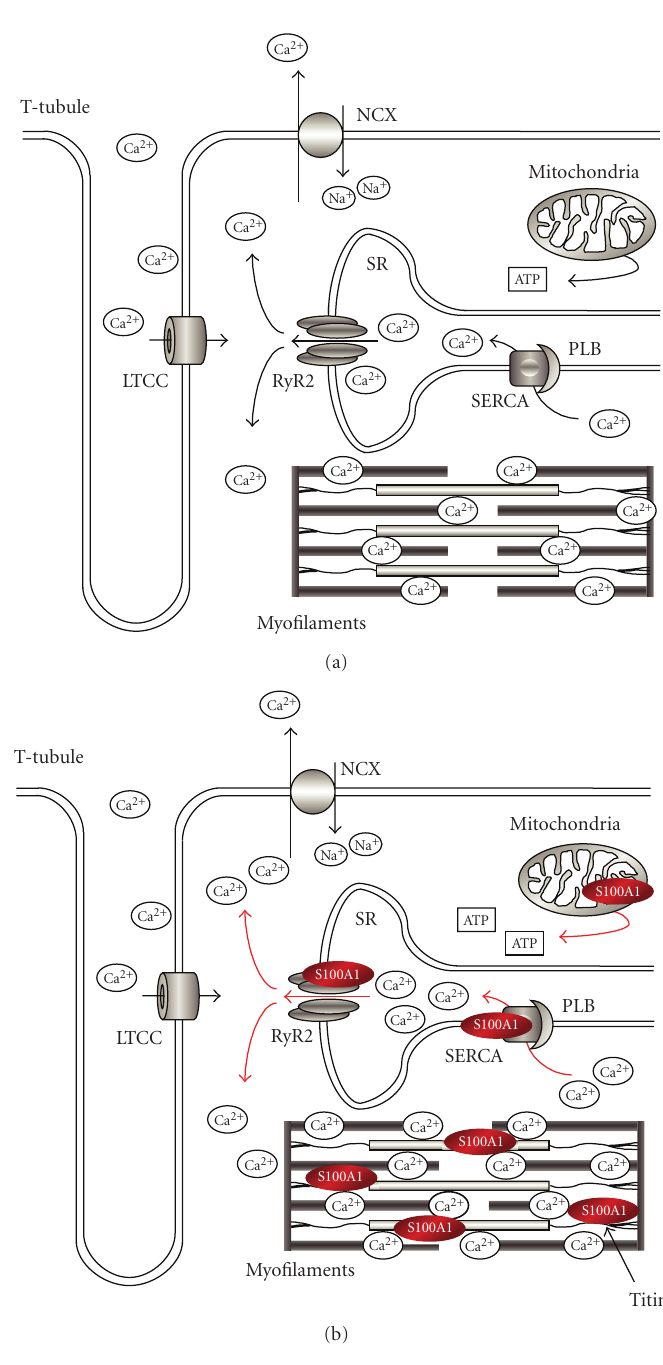
Figure 3: Proposed model for S100A1 inotropic actions in cardiomyocytes. (a) During excitation-contraction coupling, the action potential- dependent opening of the L-type Ca 2+ channel (LTCC) results in a transsarcolemmal Ca 2+ entry which triggers sarcoplasmic reticulum (SR) Ca 2+ release via Ryanodine Receptor 2 (RyR2) that in turn activates myofilament cross-bridge cycling and mechanical contraction. During diastole, the SR Ca 2+ reuptake is conducted by the SR Ca 2+ ATPase (SERCA), whereas the sodium-calcium exchanger (NCX) extrudes Ca 2+ from the cardiomyocyte to keep steady-state conditions. (b) S100A1 interacts with both RyR2 and the SERCA-Phospholamban (PLB)- complex and is present at myofilaments and mitochondria. Increased S100A1 protein levels result in an enhanced systolic SR Ca 2+ release via RyR2 without influencing LTCC activity. Augmented SR Ca 2+ release is balanced by an intensified SERCA activity leading to an improved Ca 2+ cycling and a raised force generation. Additionally, the S100A1/F1-ATPase interference in mitochondria is associated with an enhanced generation of cytoplasmic ATP in cardiomyocytes. Moreover, S100A1 inhibits the actin-titin interactions in the sarcomere, resulting in a reduced precontractile passive tension